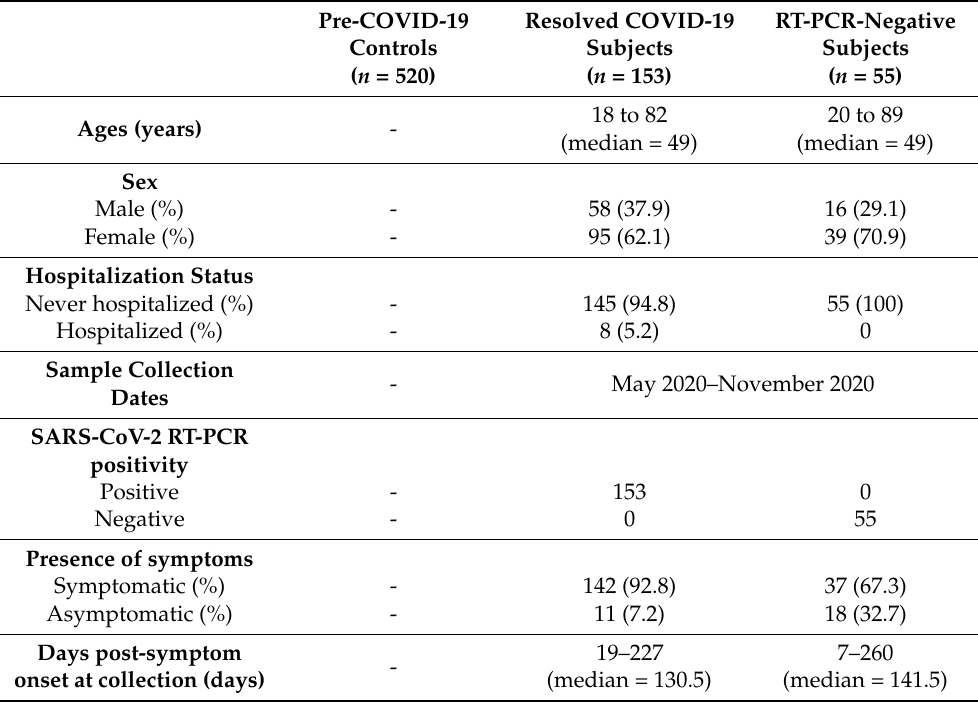
Table 1. Clinical Characteristics of Study